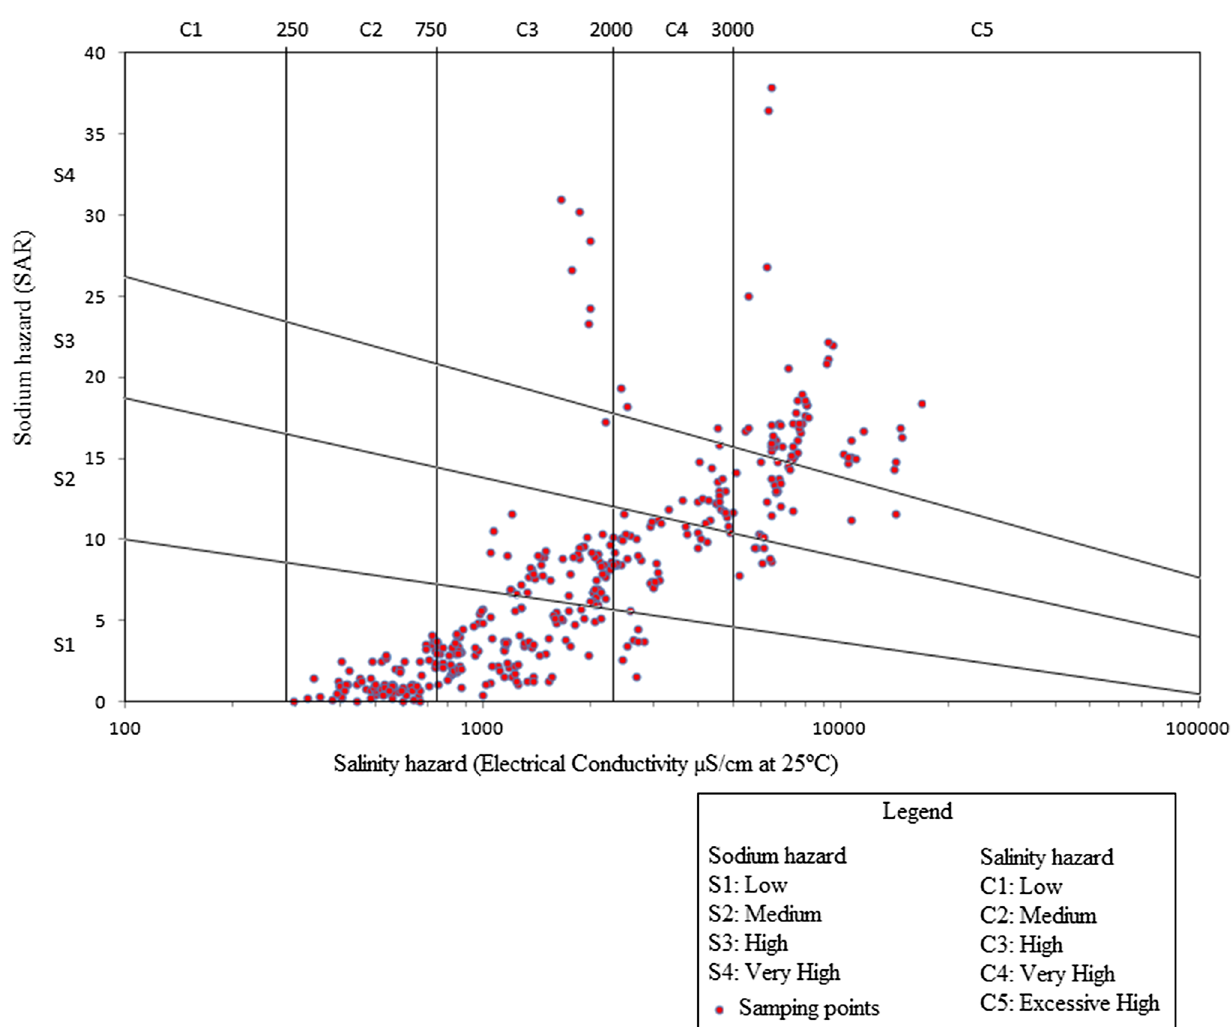
Fig. 6 USSL diagram for classification of irrigation water quality, with respect to salinity hazard and sodium